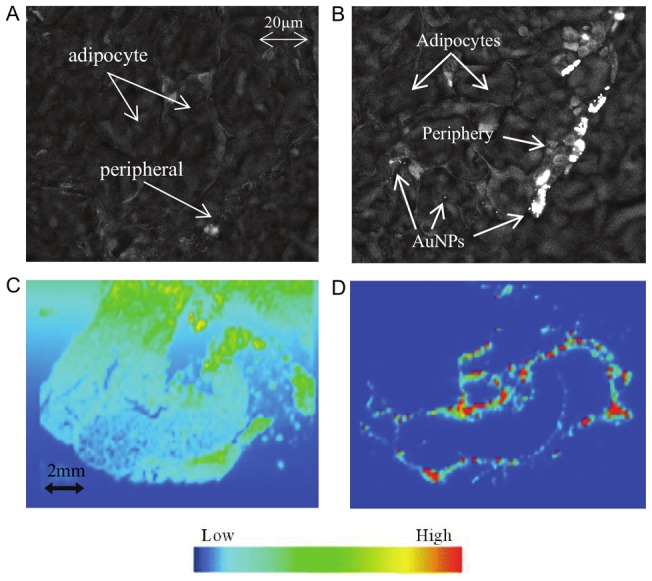
Abdominal adipose tissue distribution of AuNPs following intraperitoneal injection into mice.Scanning electron microscopy (SEM) images of abdominal adipose tissue in (A) control mouse and (B) AuNP-injected mouse at 24 h (Mag 2.01K x). (C, D) Laser ablation inductively coupled plasma mass spectrometry (LA-ICP-MS) images of abdominal adipose tissue at 24 h. (C) displaying the carbon present throughout the tissue sample, of medium to low signal intensity, (D) displays the gold present throughout the tissue sample, concentrated around the periphery of a portion of tissue within the section, of medium to high intensity. The strength of the signal transmitted for a selected element is represented by a corresponding colour, blue signifying the lowest signal strength and red the highest.